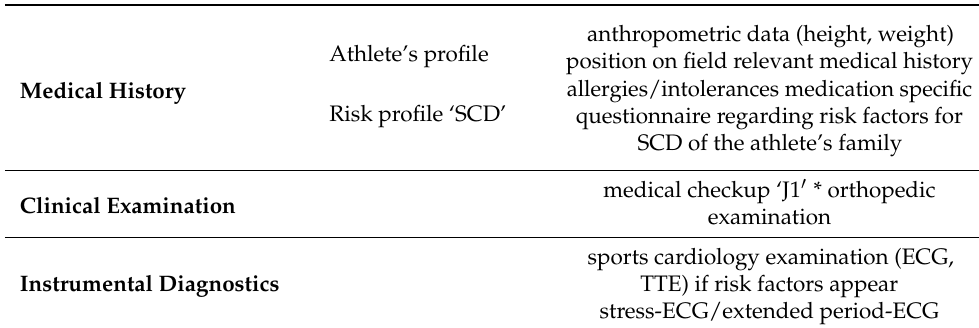
Table 3. Screening modules of the BFV’s preventive sports medicine concept. SCD—Sudden Cardiac Death, ECG—electrocardiography, TTE—transthoracic echocardiography, * German youth screen- ing